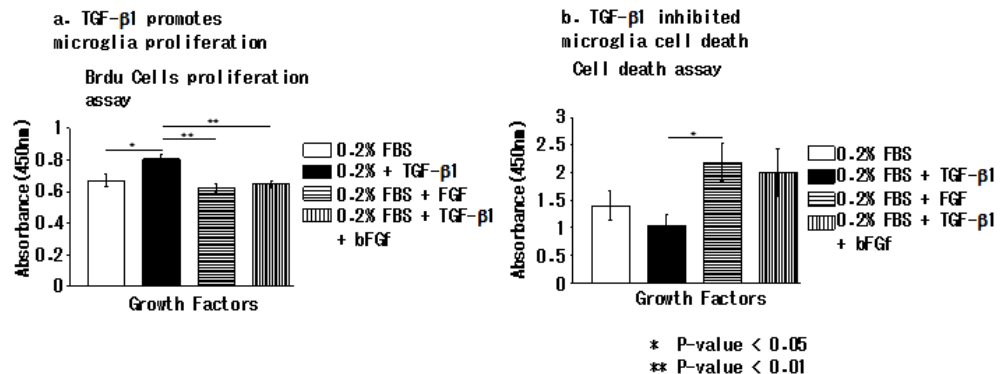
Figure 4. TGF- β promotes proliferation and inhibits cell death in microglia. ( a ) The bromodeoxyuridine cell proliferation assay revealed that TGF- β in 0.2% fetal bovine serum promoted the proliferation of microglial cells. ( b ) The cell-death assay showed that TGF- β in 0.2% fetal bovine serum inhibited microglial cell death. P < 0.05, was considered significant (Kruskal–Wallis test) Data are presented as the mean of triplicate experiments; error bars represent the standard deviation.